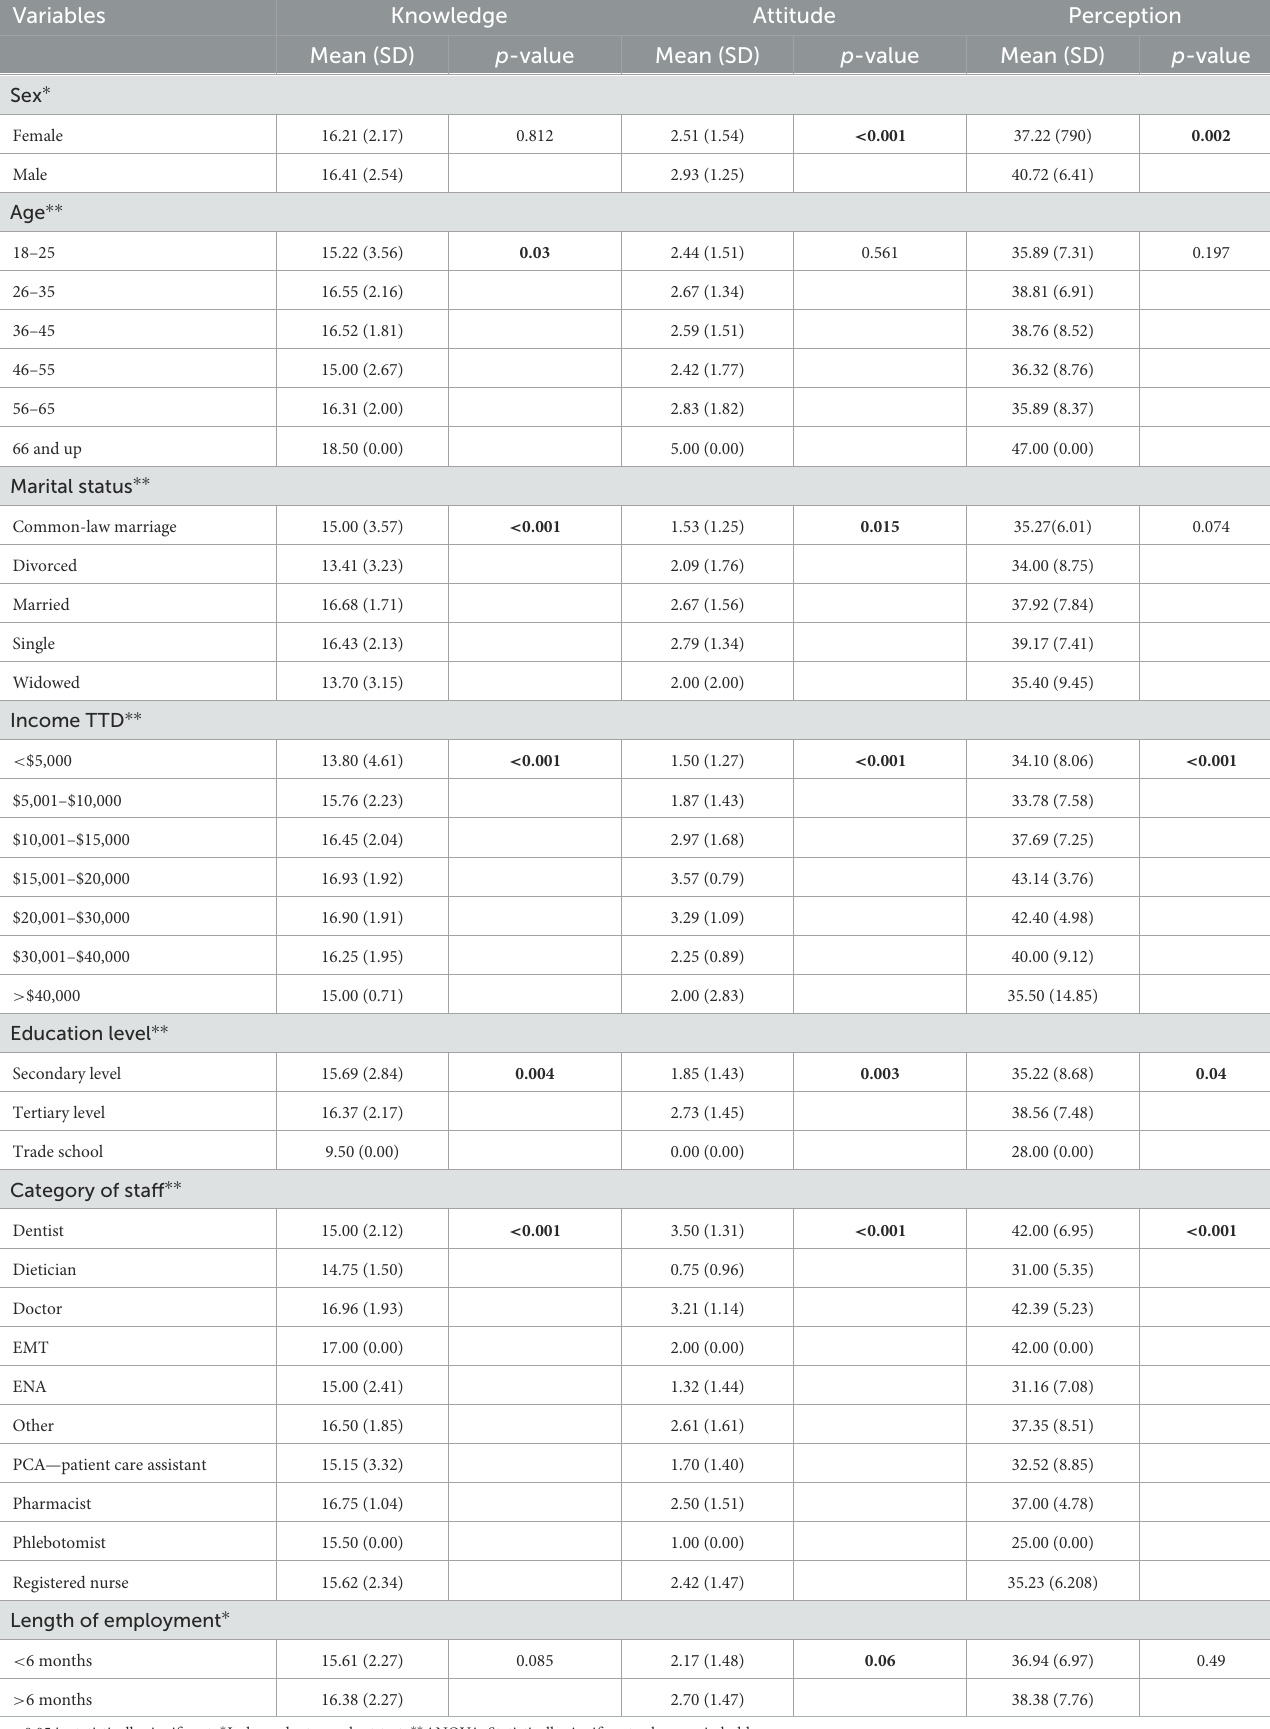
TABLE 3 Mean scores with respect to demographics and p values (independent samples t -test for two categories, ANOVA for more than